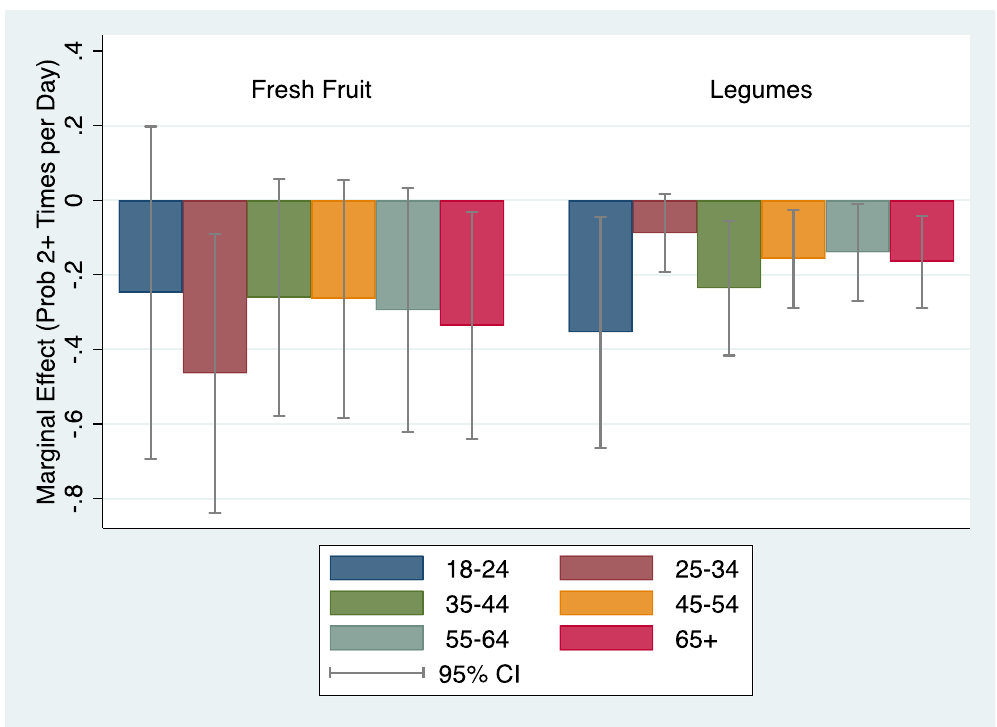
Figure 1. Differences in the association of housing price and food consumption by age group.